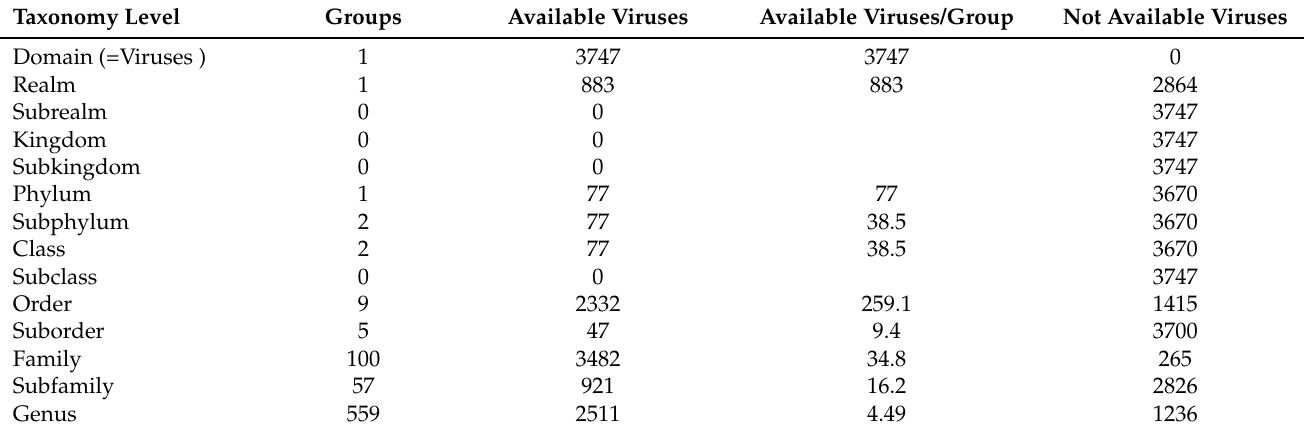
Table 1. In total, 14 taxonomic levels are available. For fitting a machine learning model, a moderate number of groups and a fair amount of available viruses per group builds a reasonable training set. Therefore, the taxonomic level of orders was chosen for the evaluation in this work.